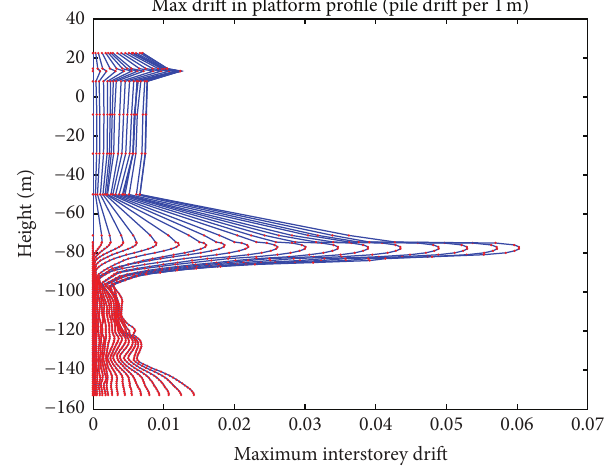
Figure 5: The profile of maximum drift ratio in different elevations of platform from the pile tip up to the deck